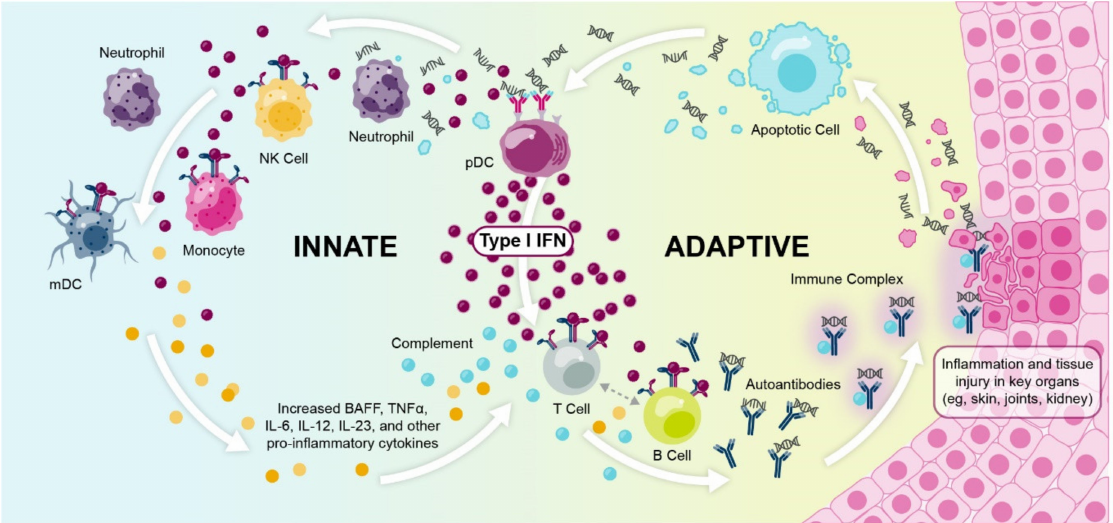
Figure 2. Type I interferons and immune complex formation contributes to organ damage in the cycle of SLE pathophysiol- ogy. BAFF, B-cell activating factor; IFN, interferon; IL, interleukin; mDC, myeloid dendritic cell; NK, natural killer; pDC, plasmacytoid dendritic cell; SLE, systemic lupus erythematosus; TNF α , tumor necrosis factor